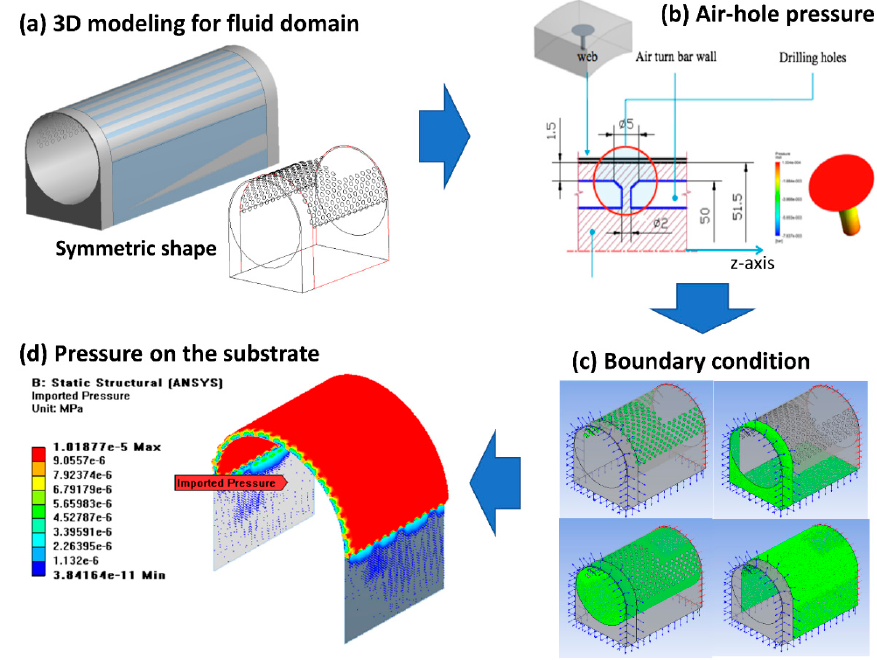
Figure 2. Summary of the FSI analysis protocol: ( a ) three-dimensional (3D) modeling of the symmetrical air bar, ( b ) determining the pressure at the air hole, ( c ) boundary conditions for the fluid simulations, and ( d ) the pneumatic pressure acting on the substrate induced by the air flow.